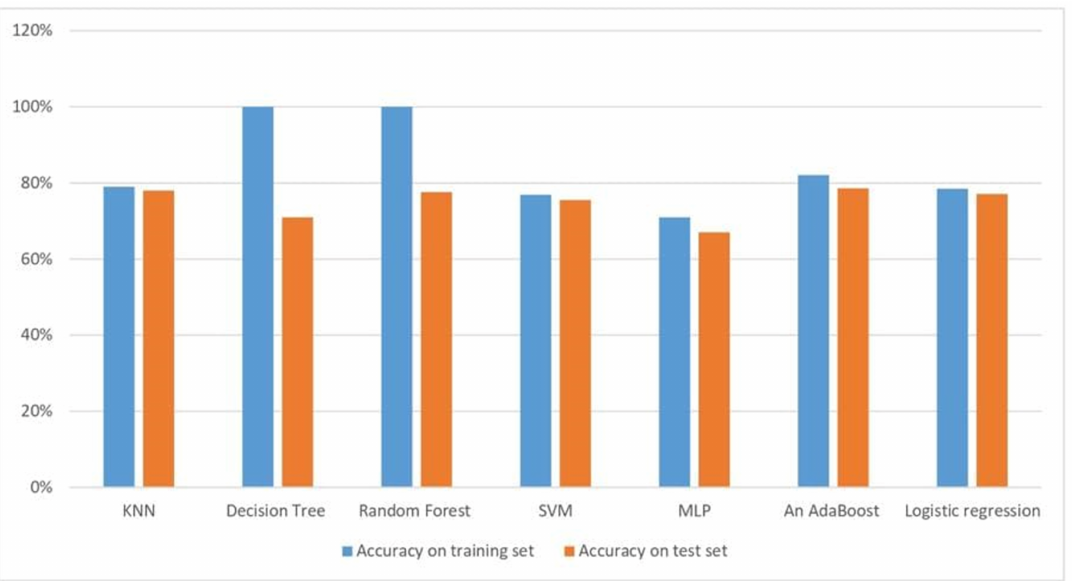
Figure 10. The first result for classification algorithms